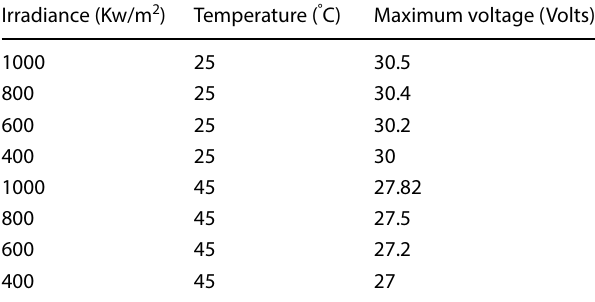
Table 2 Change in voltage as per irradiance and temperature Irradiance (Kw/m 2